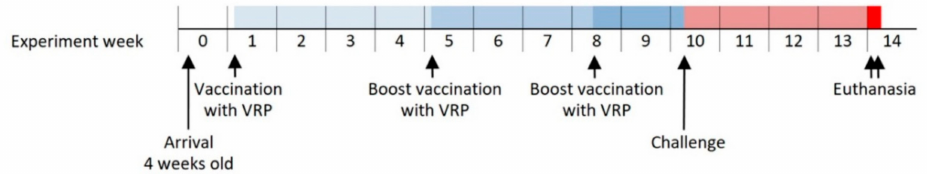
Figure 1. Timeline of the vaccine-challenge experiment indicating the major